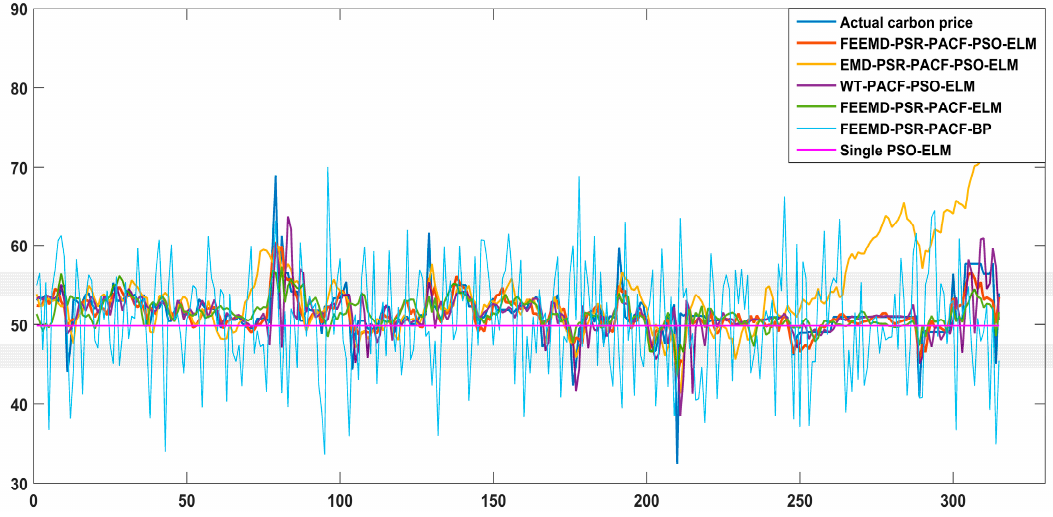
Figure 11. The forecasting curves of the Beijing carbon price. Table 8. The performance values of the prediction models under Beijing’s emissions trading scheme